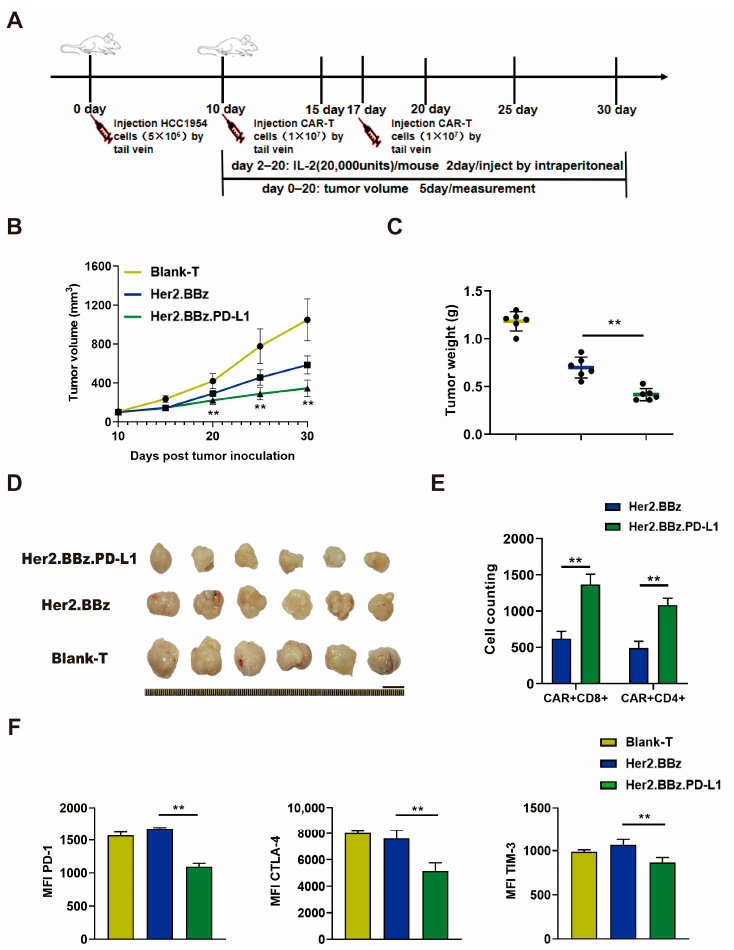
Figure 6. Anti-tumor effect of blank T, Her2.BBz CAR T, and Her2.BBz.PD-L1 CAR T cells on HCC1954 xenograft tumors. ( A ) Schematic illustration of the experimental procedure. ( B – D ) Tumor growth curves ( n = 6) ( B ), tumor weights (scattered plot, n = 6) ( C ), and tumor images ( D ) of HCC1954 xenograft tumors in NCG mice treated with CAR T cells. ( E ) T cells were isolated from 0.2 g tumor by CD3 microbeads, the number the CAR T cells was counted, and the amount of CD4 + and CD8 + cells was analyzed by flow cytometry ( n = 3). ( F ) The expression of surface markers PD-1, CTLA-4, and TIM-3 in tumor infiltrating T cells was measured by flow cytometry, and MFI was calculated using FlowJo ( n = 3). A total of three healthy donors were enrolled in in vivo experiments and the mice experiment was performed once for each donor. We present data from a representative individual. One-way ANOVA analysis was performed to determine statistical significance, the results are means ± SD (** p < 0.05, compared with Her2.BBz CAR T cells group).